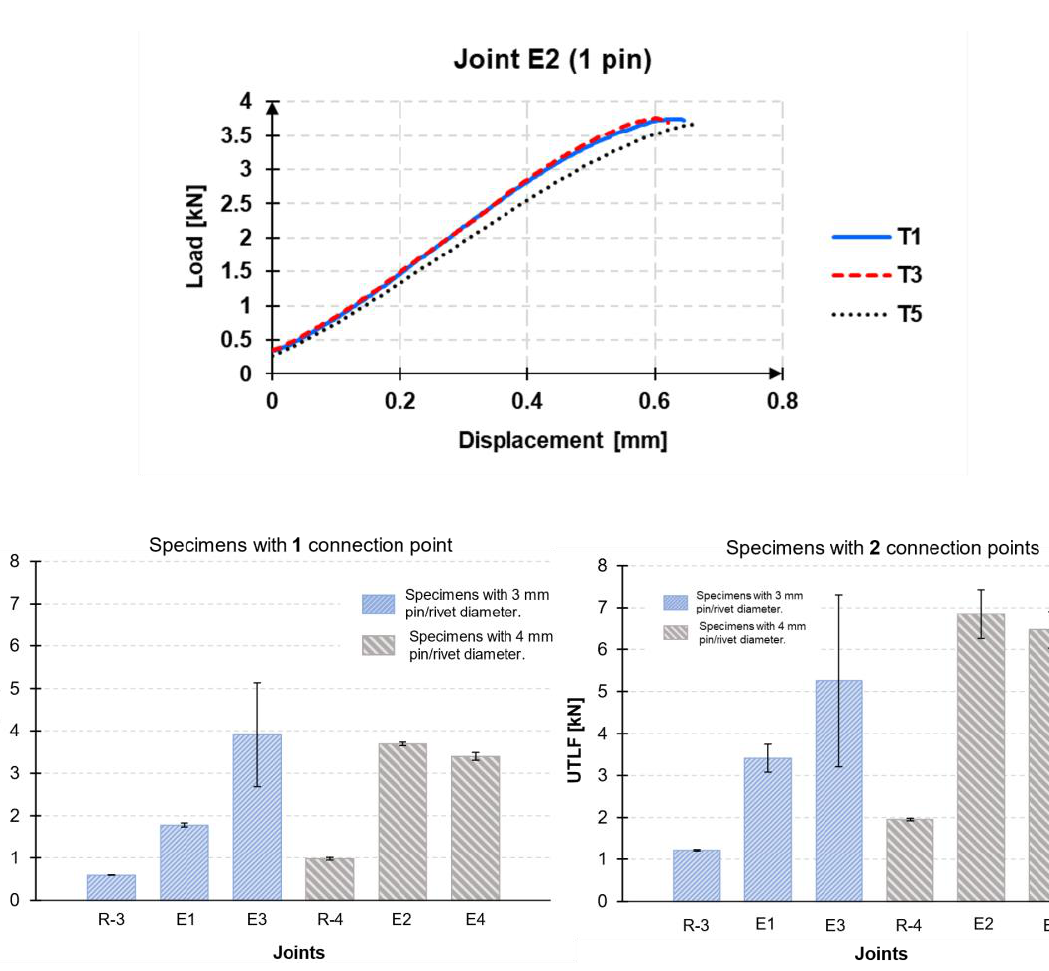
Figure 7. ( a ) Load-displacement curve of all of the tested specimens of condition E2 with one connection point; ( b ) mechanical performance of the produced joints and riveted connections with one and two connection points [R-3 and R-4: riveted joints; E1, E2, E3 and E4: AA-Ti joints produced by FSW].